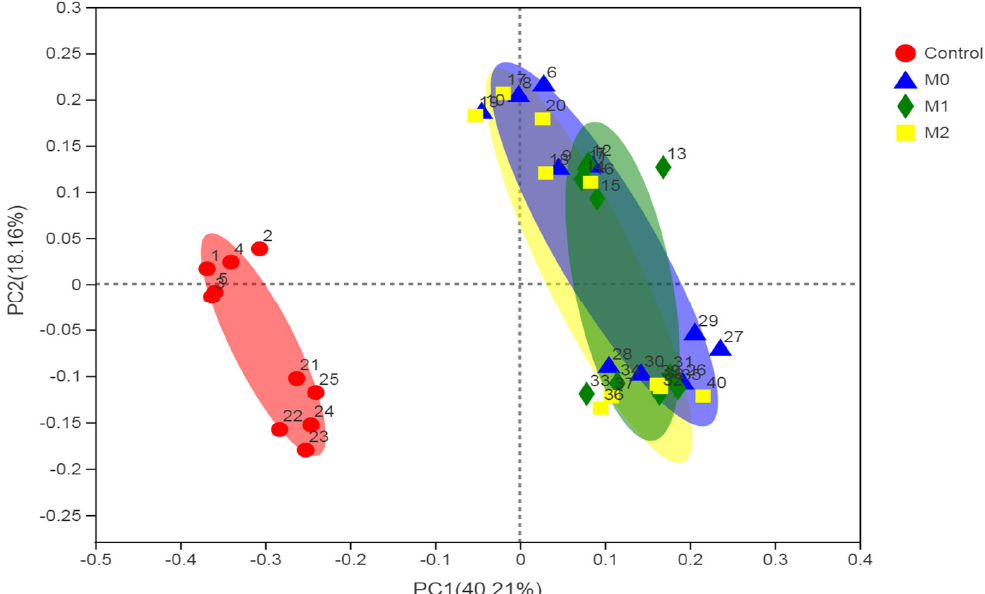
Figure 3. First two dimensions from the (non-metric) multi-dimensional scaling of the Bray-Curtis dissimilarity matrix. Samples were grouped by treatment. PERMANOVA amongst all groups p = 0.001 (using 999 permutations).